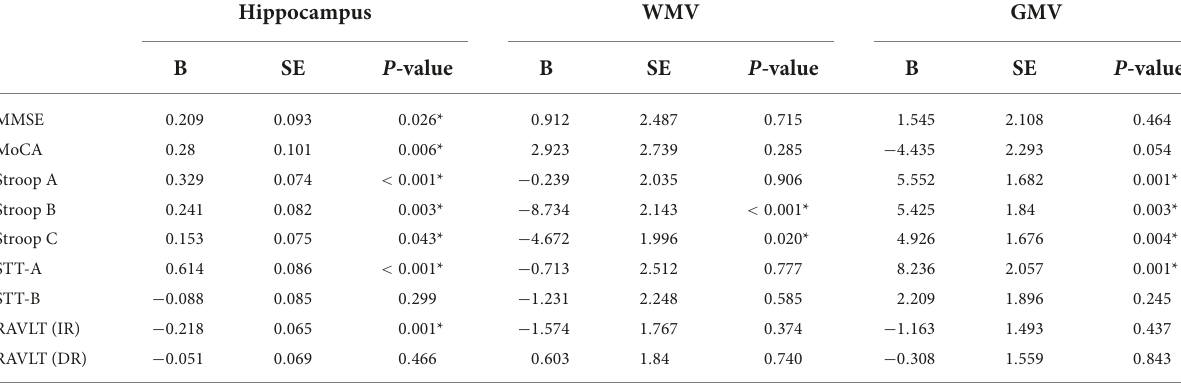
TABLE 4 Correlation between cognitive measures and brain MRI volume.